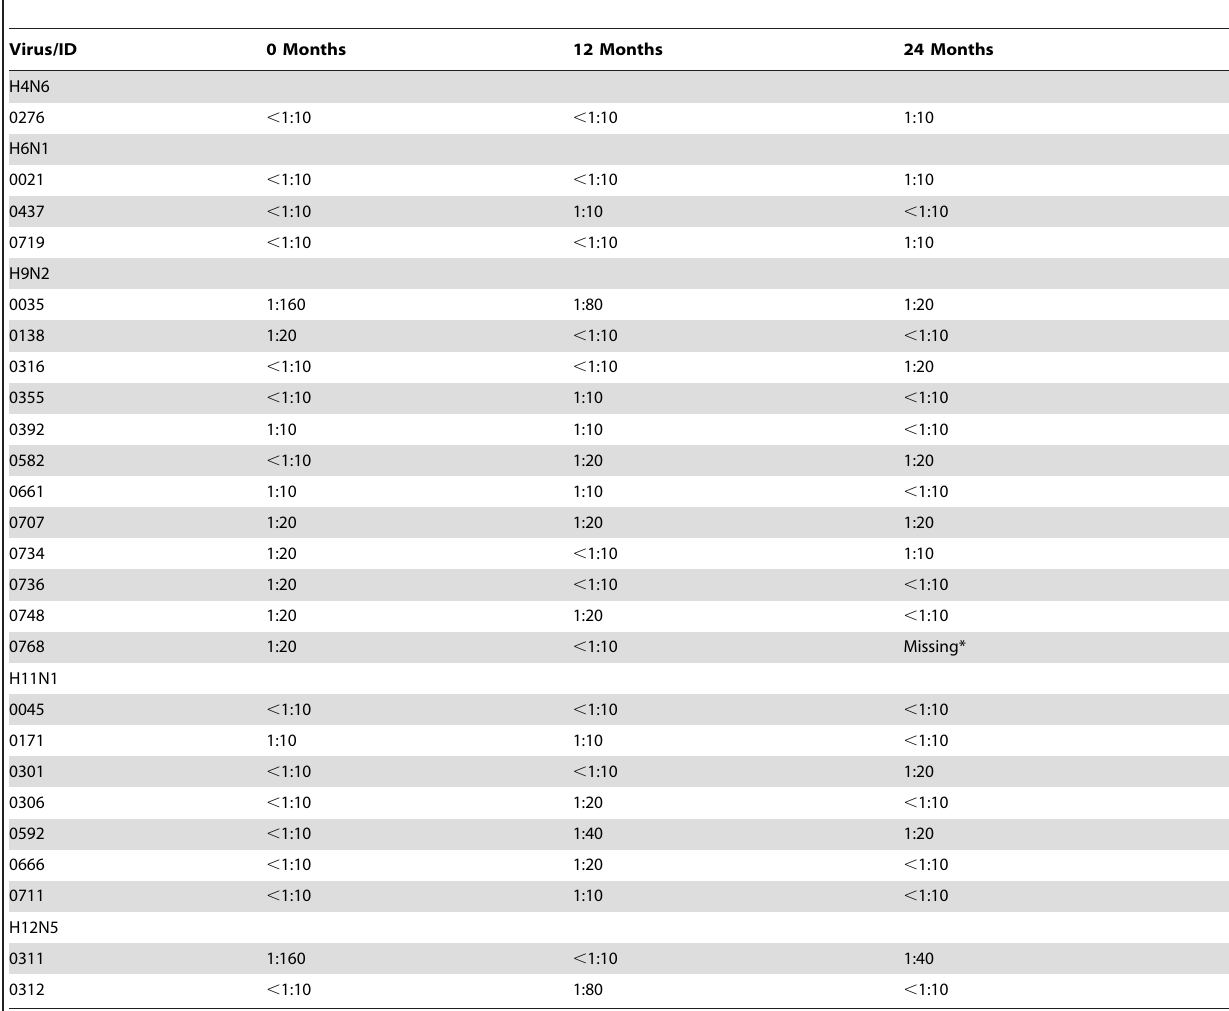
Table 3. Study participants with detectable microneutralization assays titers against avian influenza viruses at enrollment, 12- and 24-month follow-up, Kampong Cham Province, Cambodia,